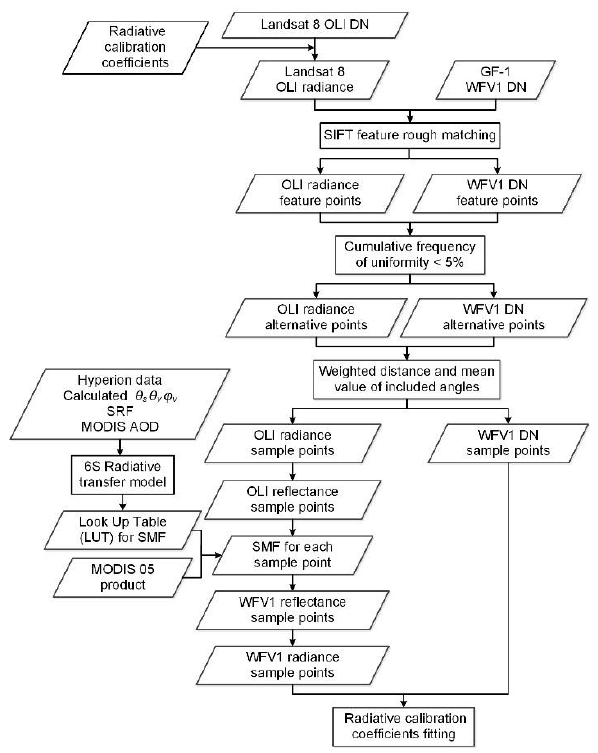
Figure 1. Process of radiometric cross calibration based on radiation and geometry